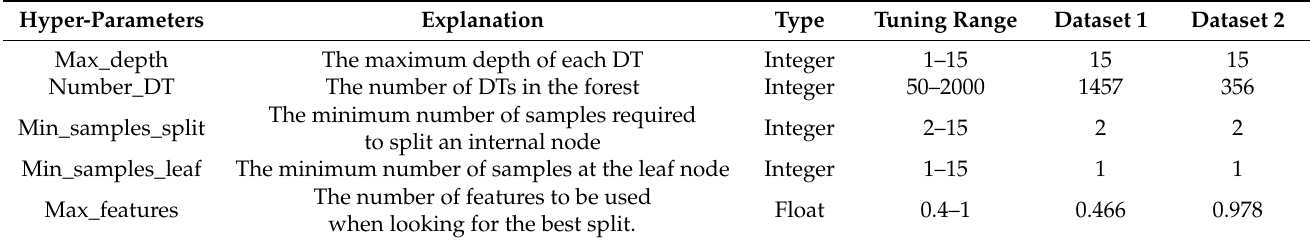
Table 2. Tuned RF hyper-parameters and their tuning outcome.